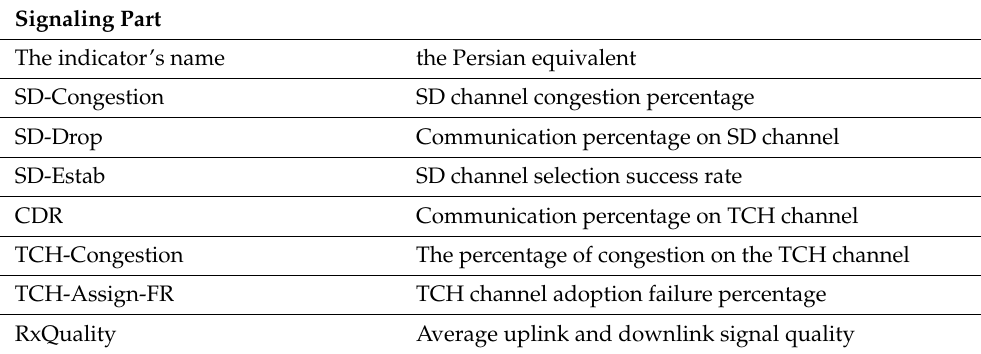
Table 1. The list of indicators used in the traffic